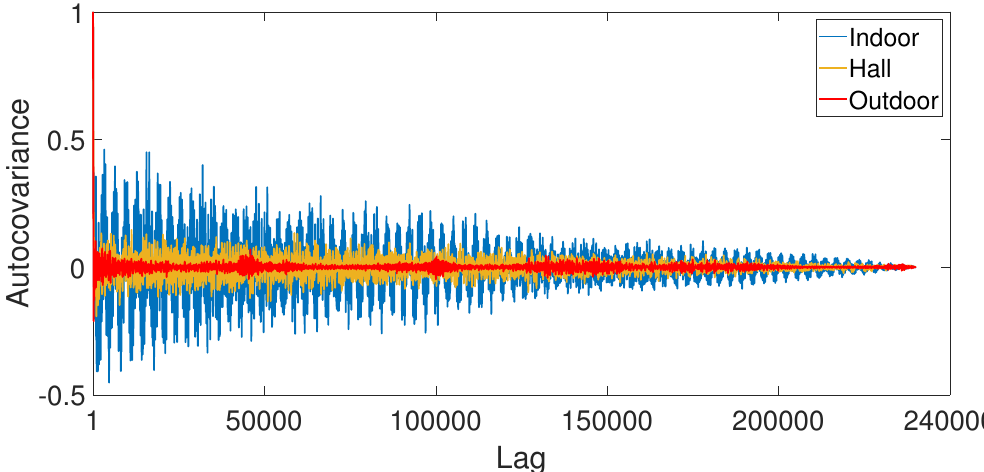
Figure 23. Autocovariance of the measured data for all scenarios (with no audio source).